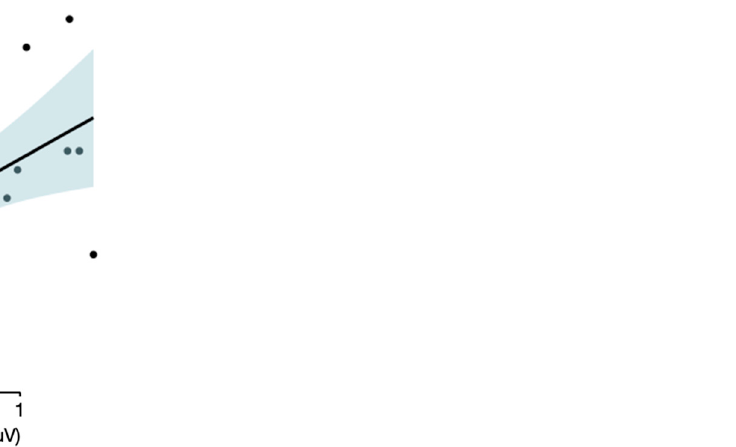
Figure 5. Grand averages for Polish (L1) and English (L2) sentences in the positive and negative mood conditions over parietal (P7, P8) and parieto-occipital (PO7, PO8) electrodes. 3.3.3. N2 Time Window (250–350 ms) The RM ANOVA performed within the N2 time frame (250–350 ms) showed a main effect of sentence type, F (1, 21) = 25.62, p < 0.001, η p2 = 0.550, whereby meaningless sen- tences elicited larger N2 amplitudes than meaningful sentences. There was also a main effect of language, F (1, 21) = 46.07, p < 0.001, η p2 = 0.687, such that Polish (L1) sentences elicited more pronounced N2 amplitudes than English (L2) sentences. The analysis also revealed a main effect of mood, F (1, 21) = 5.47, p = 0.029, η p2 = 0.207, whereby the N2 am- plitudes were more pronounced in the positive than the negative mood condition.